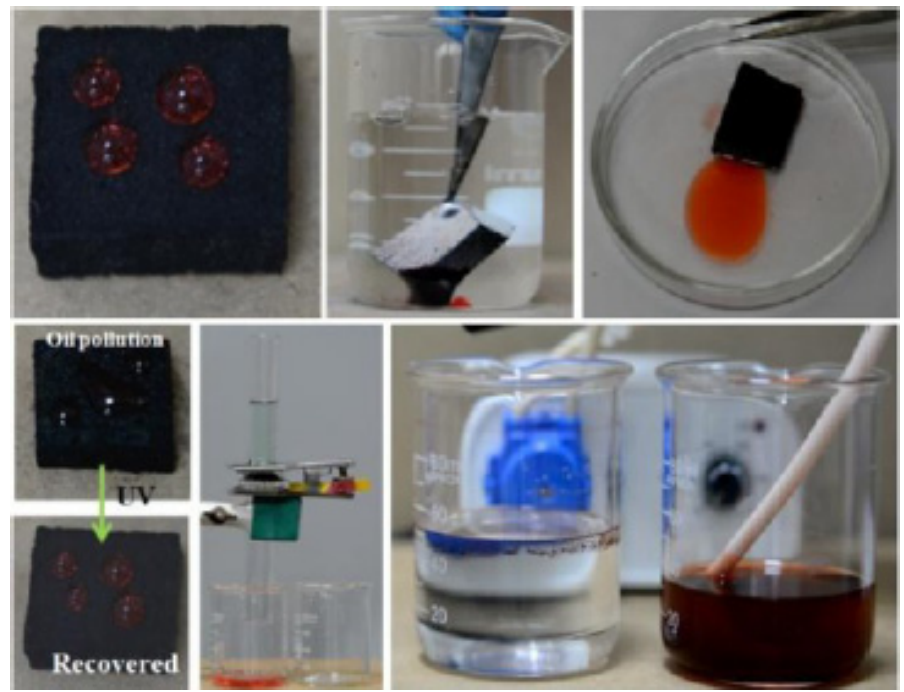
Figure 2. Illustration of the applicability of an activated carbon-TiO 2 -PDMS coated superhydro-